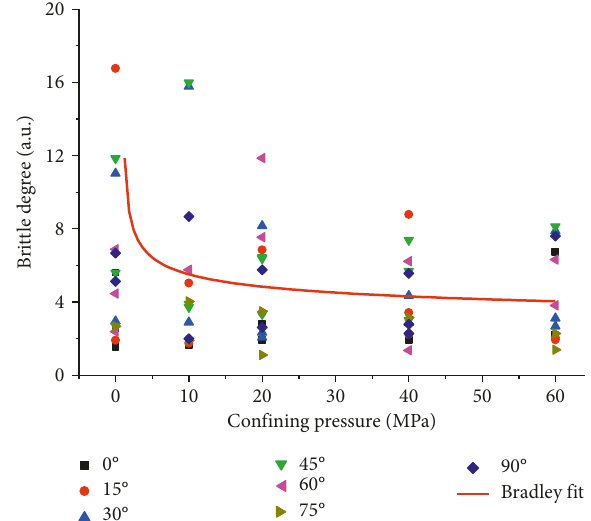
Figure 13: Relationship between brittleness and confining